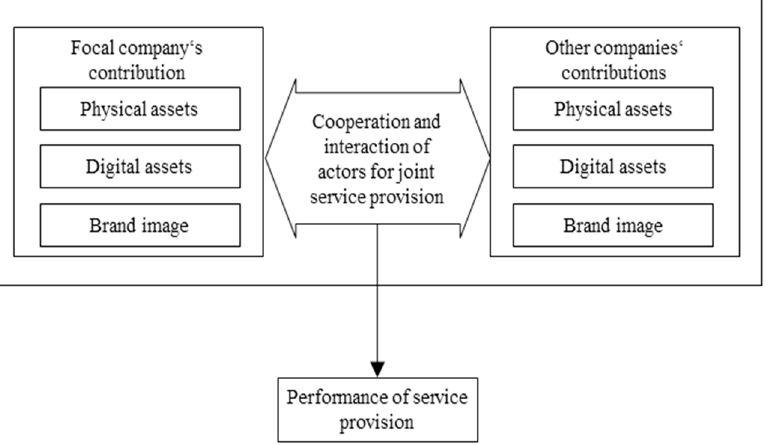
Figure 3. Presumed relationship between actors’ cooperation and performance of service provision (own figure).